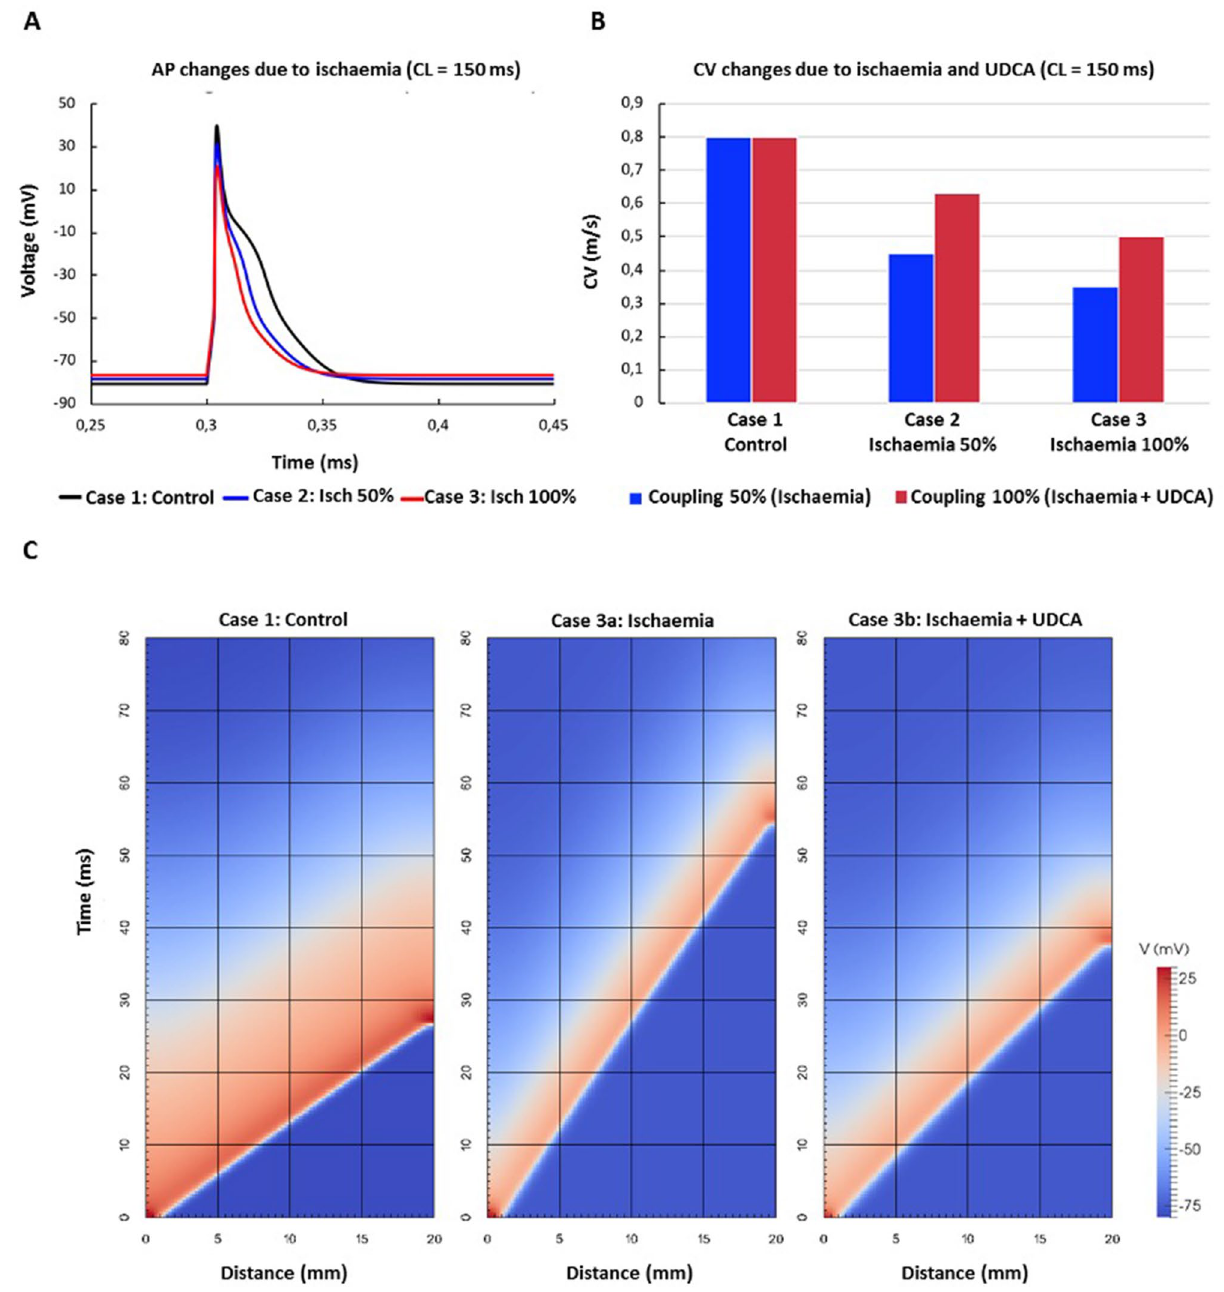
Figure 6. Effects of ischaemia and UDCA in mathematical models of rat ventricular cell and tissue. ( A ) Single cell action potential (AP) in the three cases considered (see “Results” section): control, 50% and 100% ischaemia. Ischaemia leads to progressive decreases of action potential duration (APD) and amplitude, and elevation of resting potential. ( B ) Conduction velocity (CV) in 2D rat ventricular tissue model in the same cases; in combination with ischaemia-induced reduction in cellular excitability, 50% reduction in the intercellular coupling (blue bars) leads to substantial decreases of CV; application of UCDA increases the coupling, and hence CV (red bars). ( C ) Space–time plots illustrating AP conduction along a scan line in 2D rat ventricular tissue model; 100% ischaemia (case 3a, see “Results” section) substantially slows down conduction, whereas an additional effect of UDCA (case 3b) partially restores the conduction, but not the cellular AP